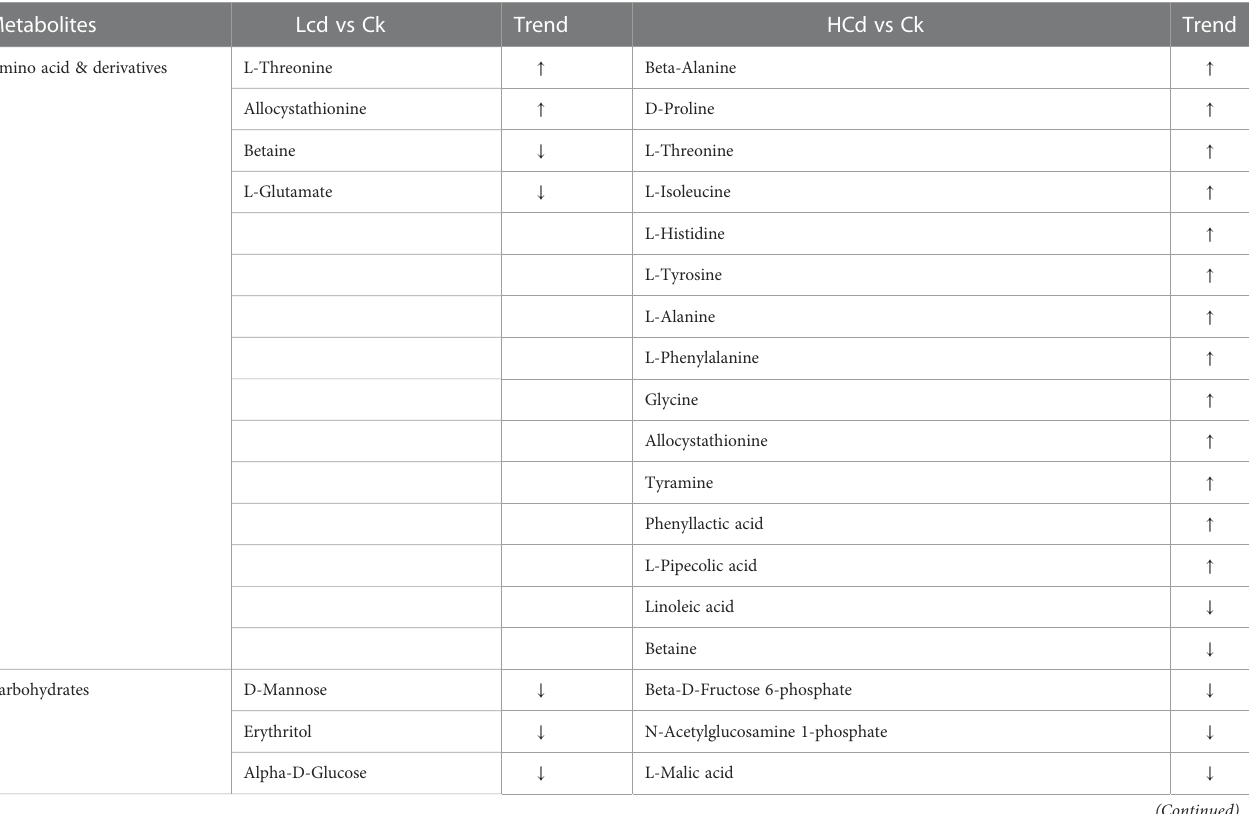
TABLE 2 Signi fi cantly expressed metabolites in the studied deep-sea mussel in response to a low and high dose of cadmium exposure (Note: Symbol ↑ indicates the metabolite is upregulated ； Symbol ↓ indicates the metabolite is downregulated). Metabolites Trend Amino acid & derivatives